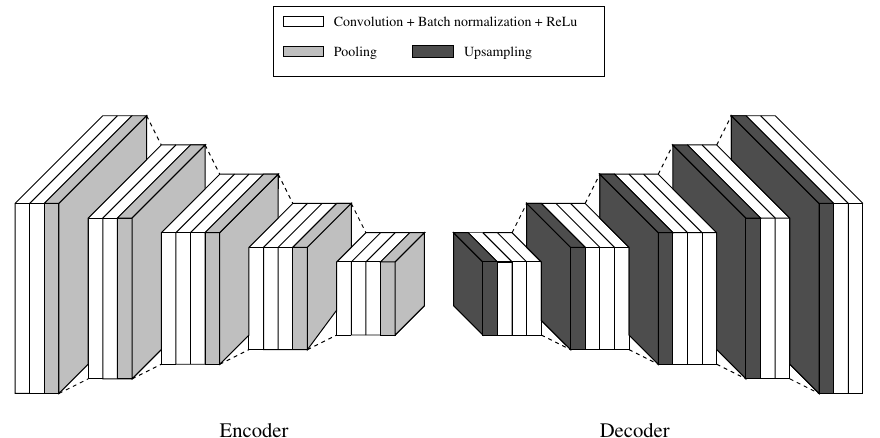
Figure 7. The pixel semantic segmentation SegNet CNN network used in the article. The encoder is placed on the left, while the decoder is placed on the right.